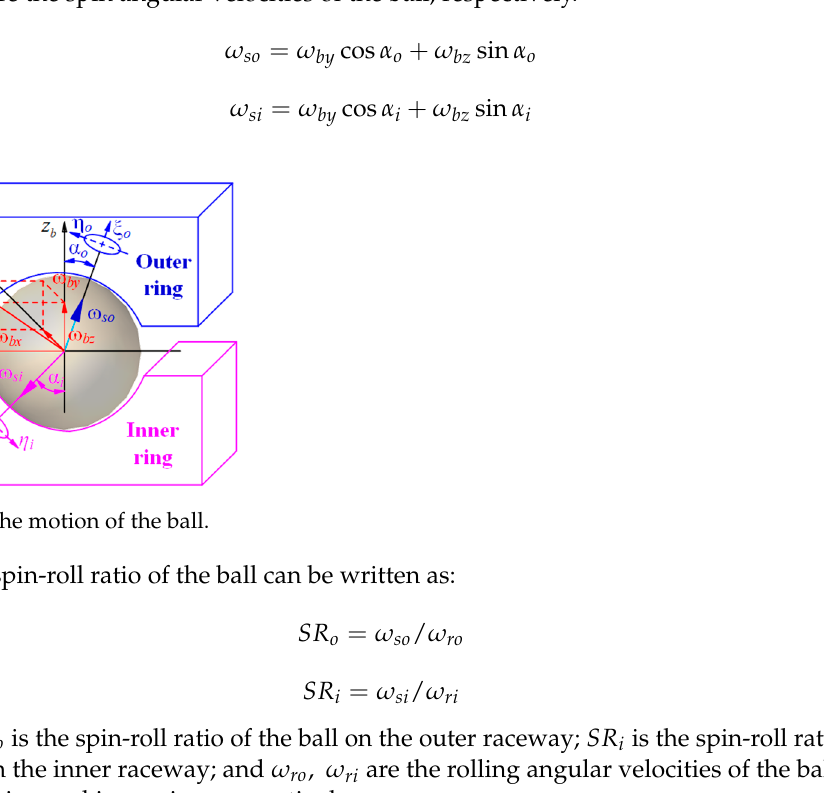
Figure 8. Forces between the j th ball and the cage. The forces acting on the cage are shown in Figure 9.